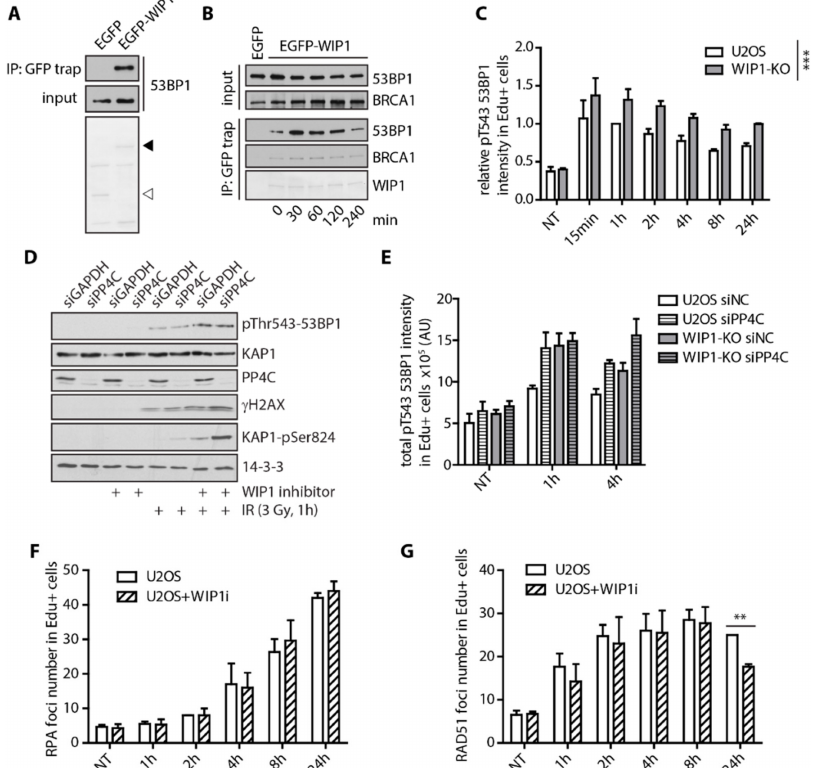
Figure 4. WIP1 delays recruitment of BRCA1 and dephosphorylation of 53BP1 at T543. ( A ) Co- immunoprecipitation of WIP1 and 53BP1. HEK293 cells were transfected with either empty GFP or GFP-WIP1, subjected to immunoprecipitation using GFP-Trap 24 h after transfection and by Western blotting with 53BP1 antibody. Ponceau staining with indicated positions of GFP (empty arrowhead) and GFP-WIP1 (full arrowhead) are